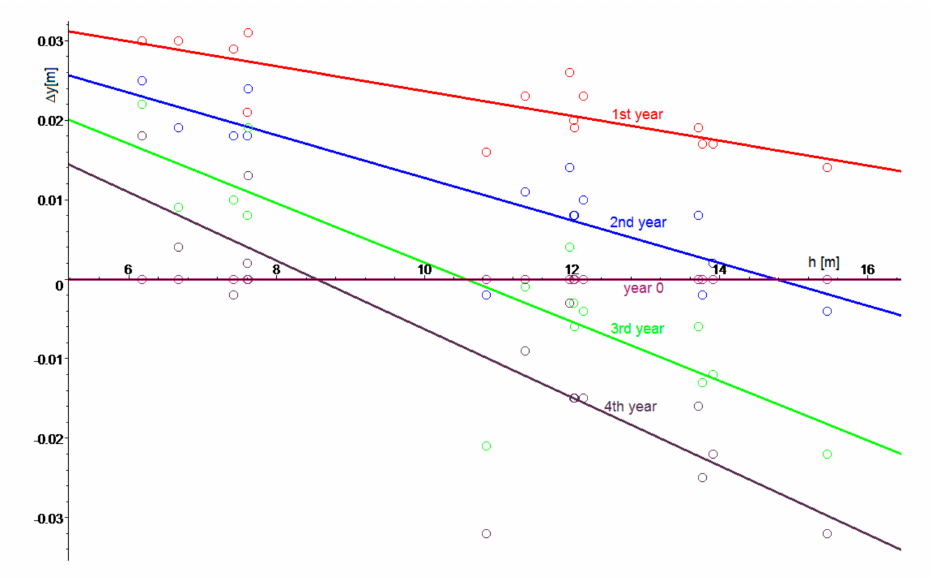
Figure 8. Vertical displacement in dependence on the material layer thickness and time.